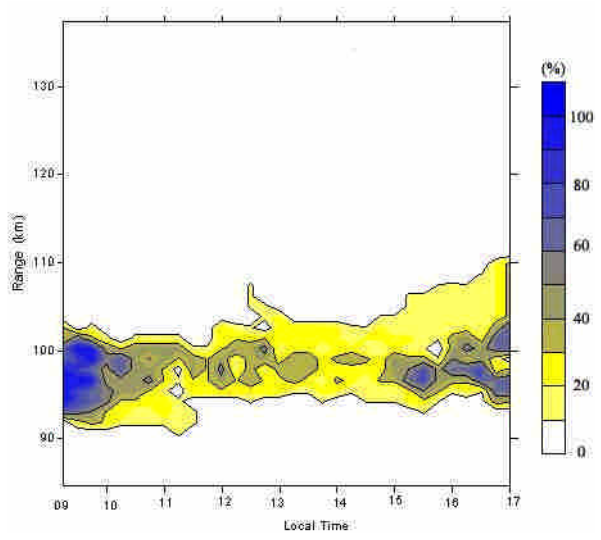
Fig. 2. The occurrence percentage of the daytime (09:00–18:00 LT) Fig. 2 E-region FAI echoes with a minimum of − 6dB SNR level and 15min × 1.2km time-range resolution bin.